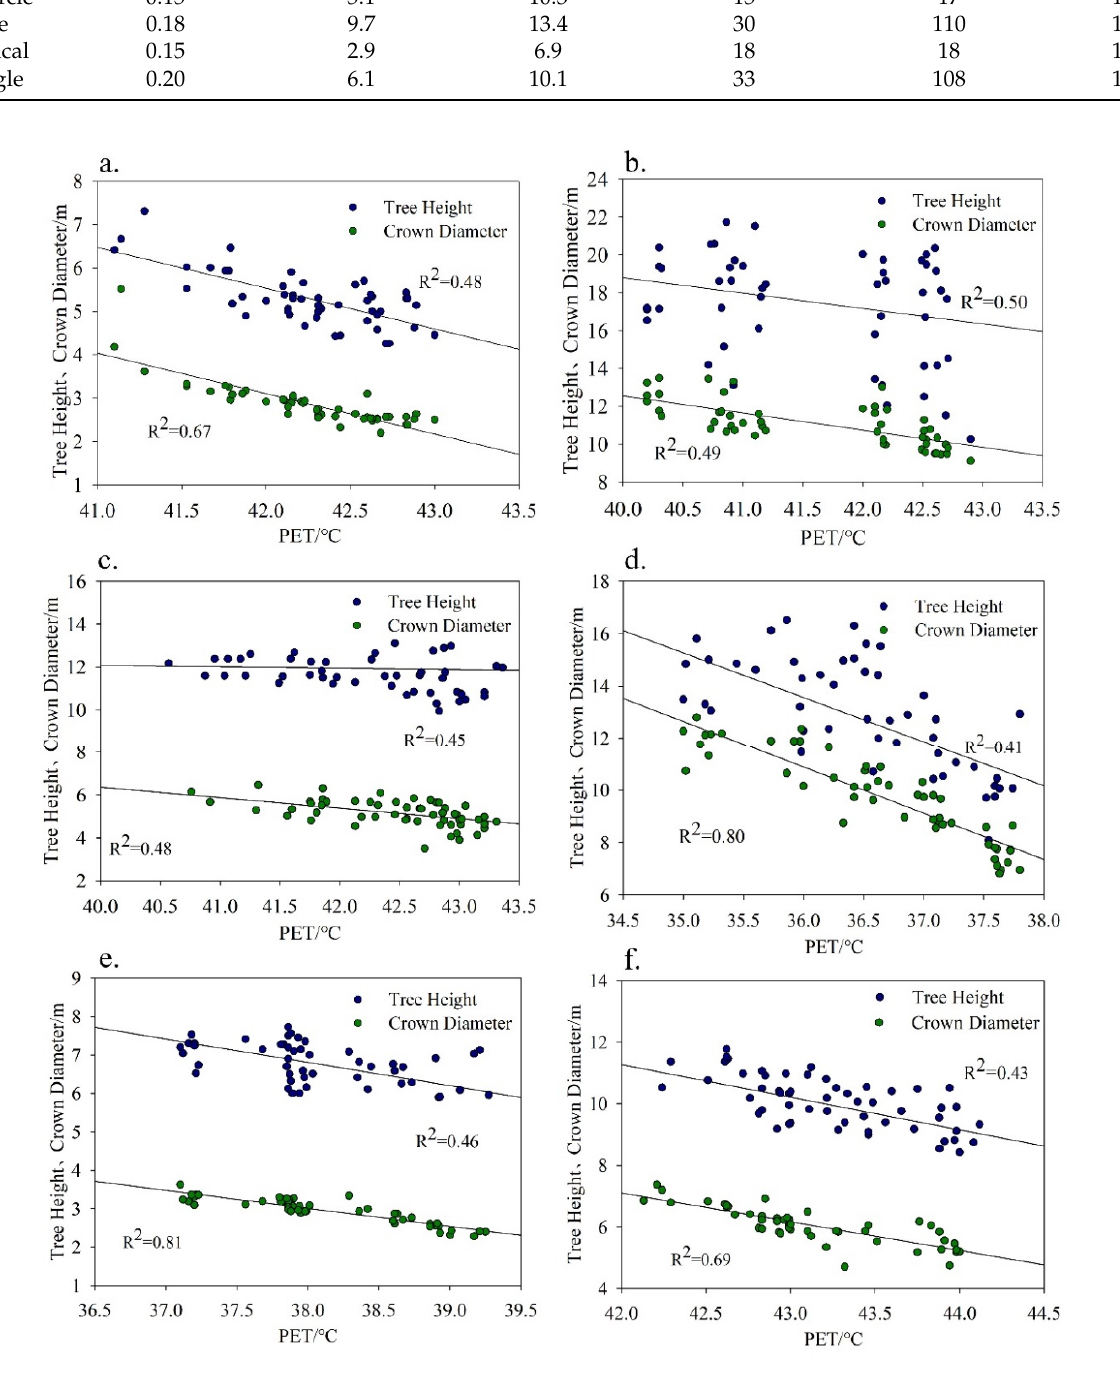
Figure 9. Linear relationship between canopy geometric features and PET.